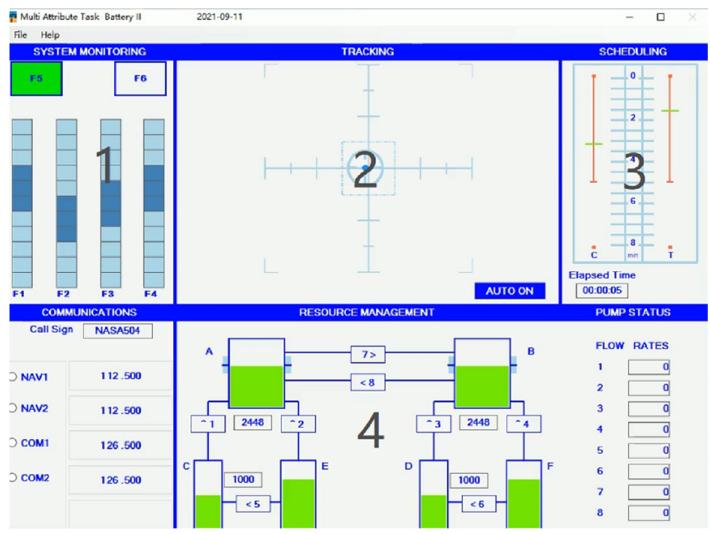
Figure 1. Area 1, 2, 3 and 4 are four tasks interface of MATB-II. Table 1. Details of four